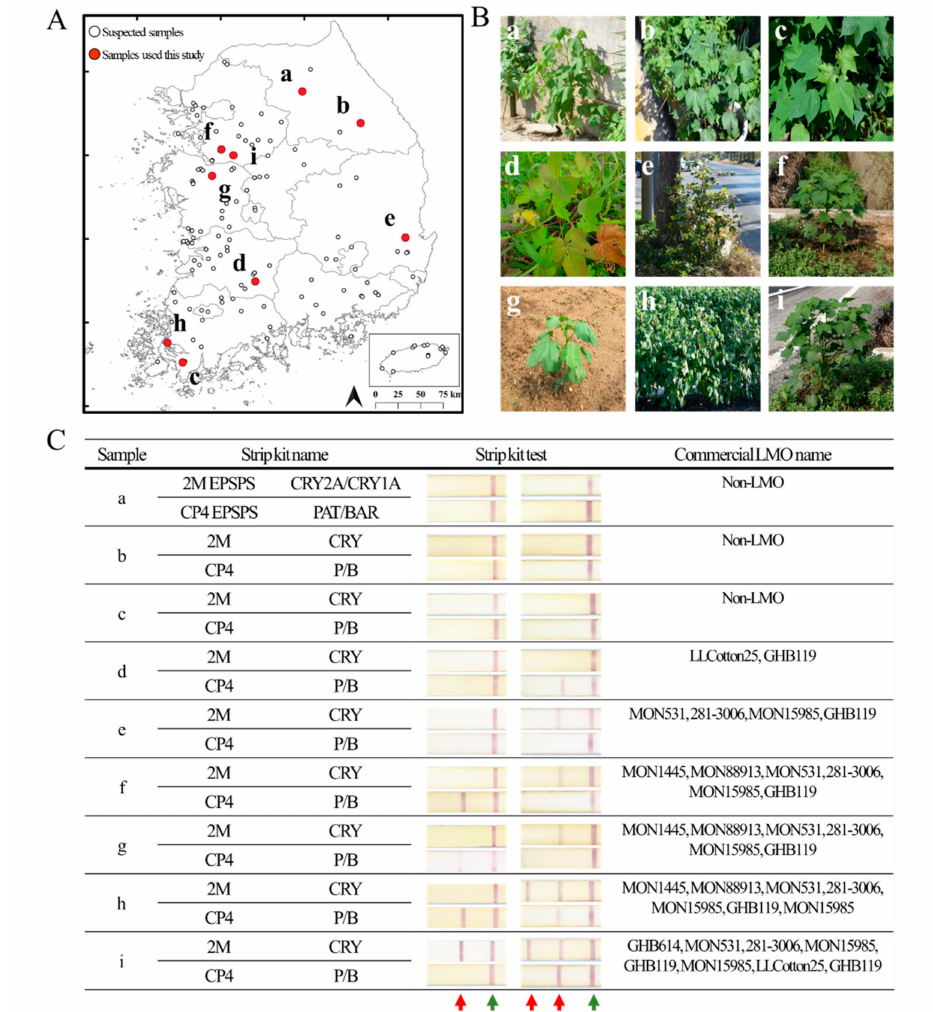
Figure 1. Result of living modified organism (LMO) environmental monitoring of cotton and strip kit test in 2017. ( A ) Location of suspected samples of living modified (LM) cotton in environmental monitoring (white spot; suspected samples, red spot; samples used this study). ( B ) Field photo of suspected LM cotton used in this study in nine sites. ( C ) Result of strip kit tests (2 M: 2 M EPSPS; CRY: CRY2A / CRY1A; CP4: CP4 EPSPS; P / B: PAT / BAR) and putative event (red arrows: Positive band of strip kit; green arrows: Control band of strip